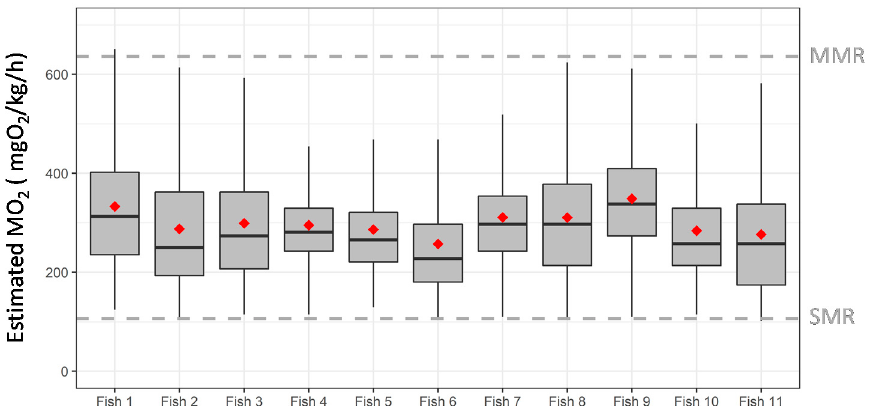
Figure 6. Boxplot of the estimated oxygen consumption rate (MO 2 , mgO 2 /kg/h) of implanted rainbow trout ( Oncorhynchus mykiss ) over the experimental period in aquaculture facility (case study). The central line of the boxplot indicates the median and the boxes indicate the quartiles, with the whiskers covering 95% of the values (n = 11 implanted fish). Mean value is represented for each fish with red square. The standard metabolic rate (SMR) and maximum metabolic rate (MMR), estimated during U crit trials, are indicated using the dashed grey